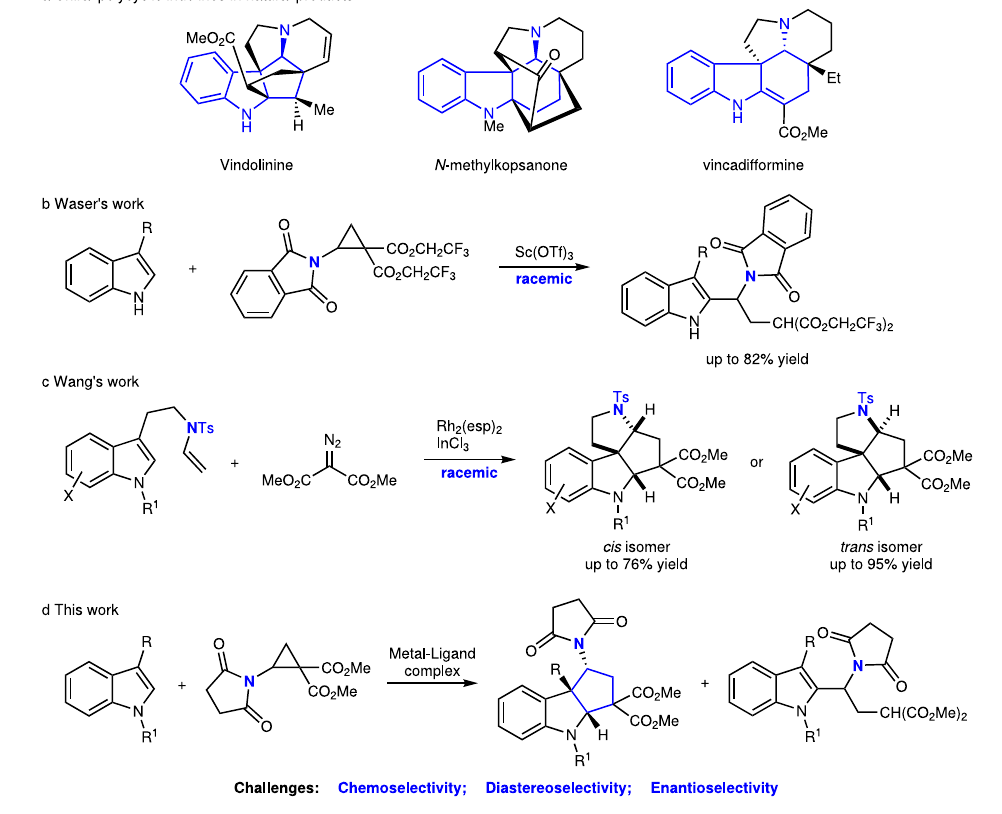
Fig. 1 | Signi fi cances and reactions of D-A cyclopropanes with substituted indoles. a Chiral polycyclic indolines containing cyclic amine fragments in natural products. b Previous work: the reaction of D-A aminocyclopropanes with C3- substituted indoles produces C2-alkylated product from Waser et al. c Previous